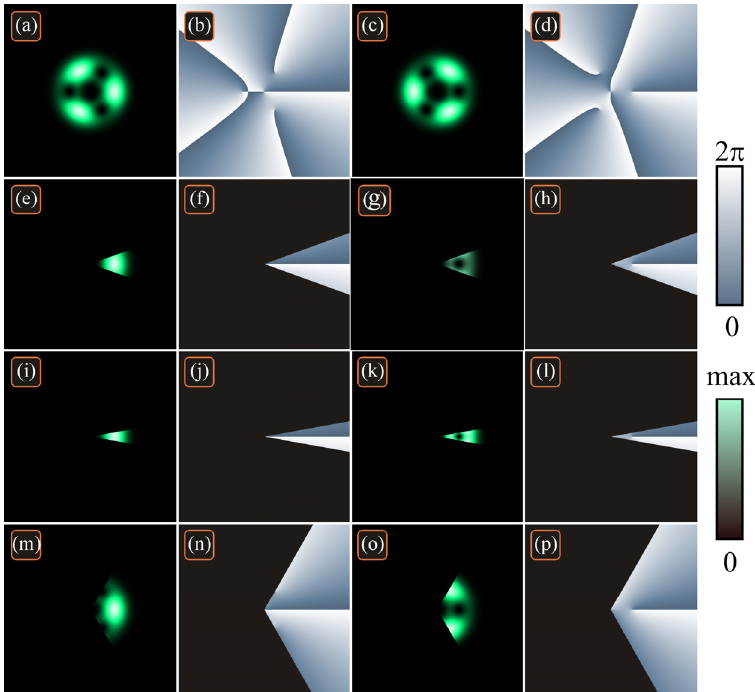
Figure 4. Intensity (1st and 3rd columns) and phase (2nd and 4th columns) distributions of superpositions of two single-ringed LG beams with different energies passing through sector apertures with different angles.